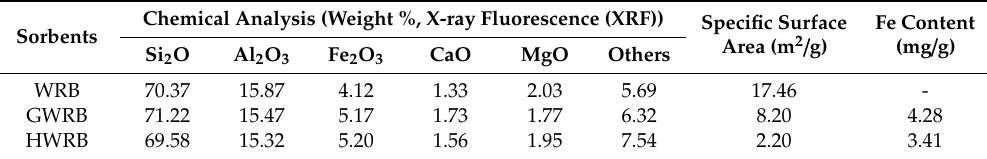
Table 2. The chemical analysis, specific surface area and amount of coated iron on the surface of adsorbents.